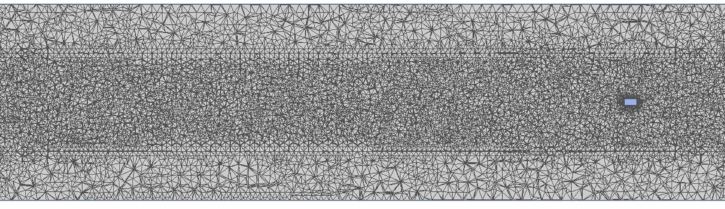
Figure 2. Computational grid of circular cylinder.